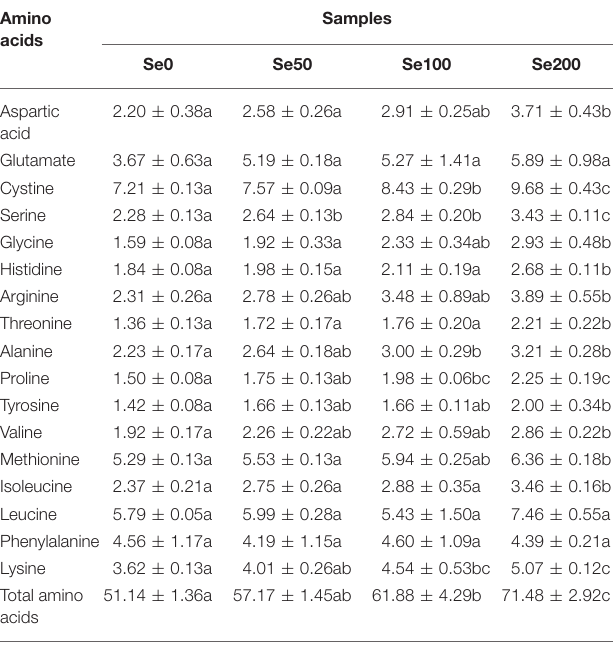
TABLE 4 | Contents of hydrolyzed amino acids (g kg − 1 DW) in different samples. Amino